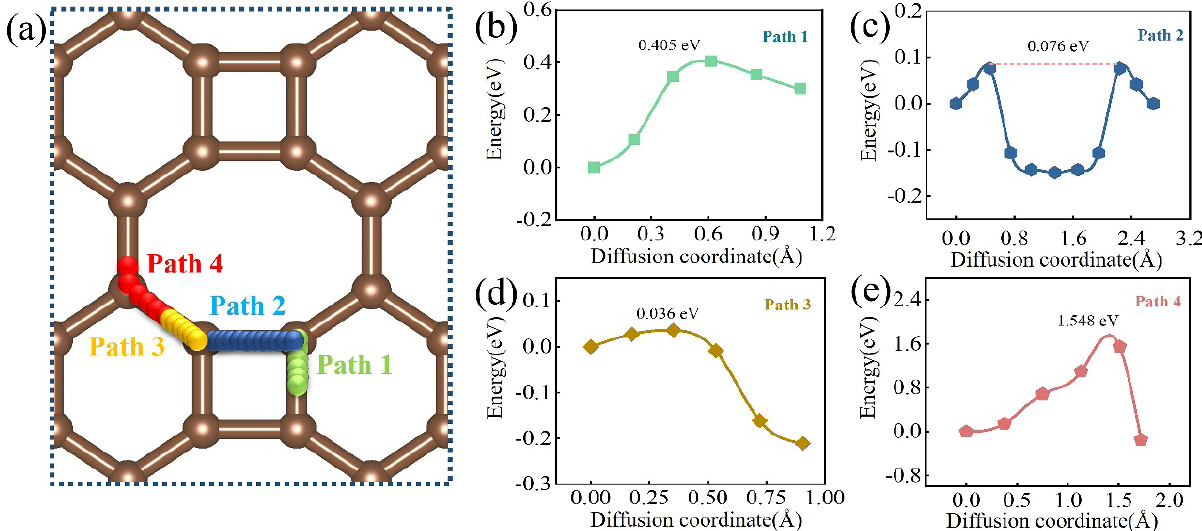
Figure 6. The diffusion behavior of O atoms on biphenylene monolayer. ( a ) O atom diffusion paths. ( b – e ) Minimum energy pathways and migration barrier of Paths 1 − 4.